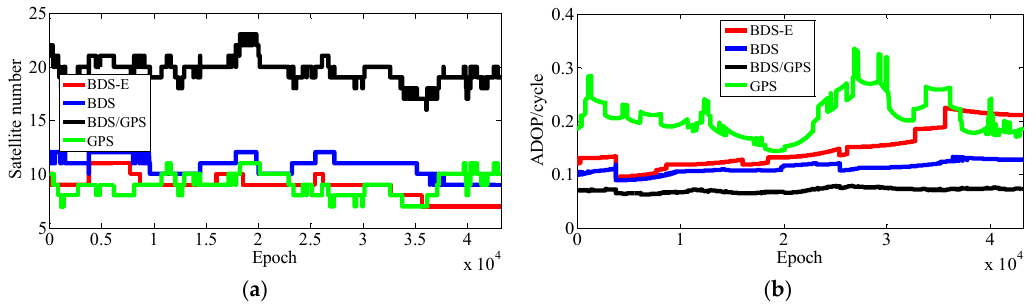
Figure 7. Satellite number and ADOP of four systems for group A. ( a ) The satellite number of four systems for group A. ( b ) The ADOP of four systems for group A.